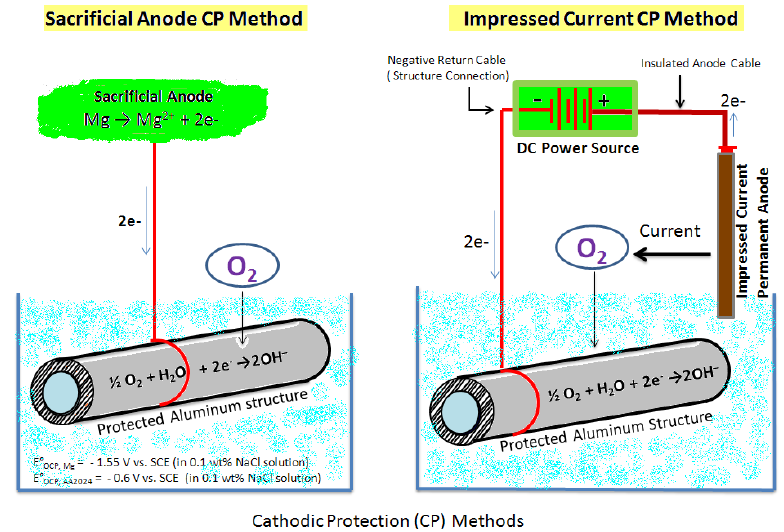
Figure 1. Schematic showing cathodic protection methods using sacrificial anode and impressed